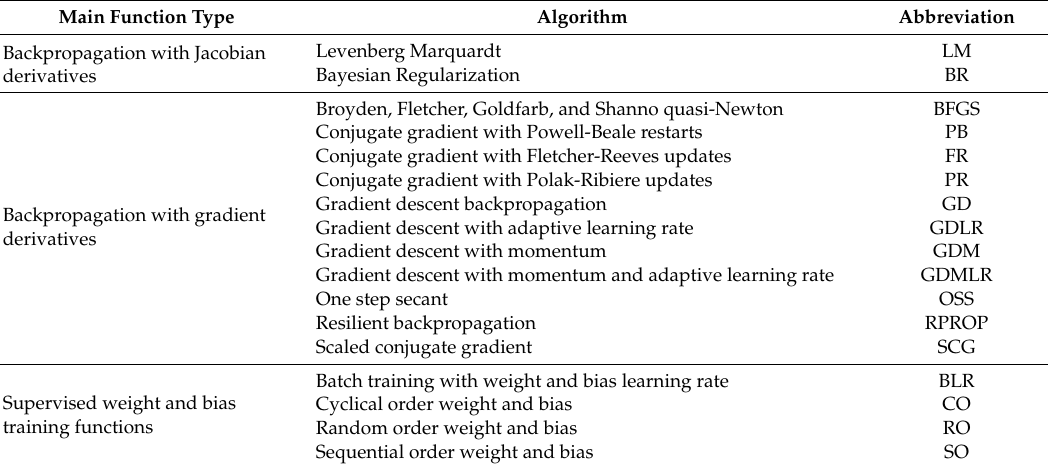
Table 2. Algorithms used and description of the main function type and abbreviations, which were used to develop the artificial neural network models.